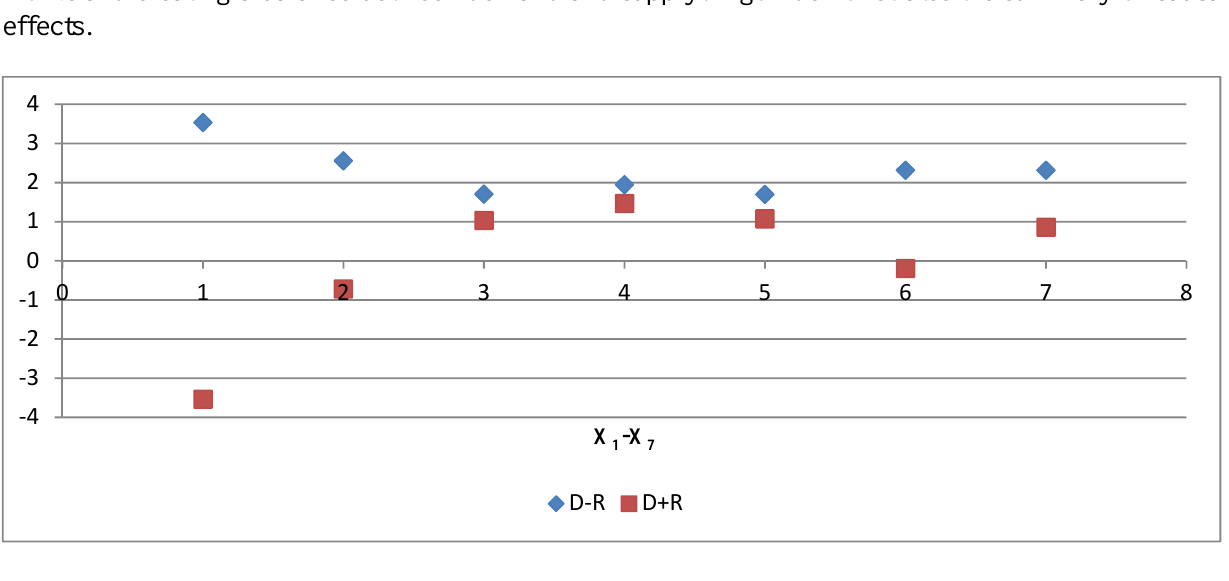
Fig. 1. The cause and effect